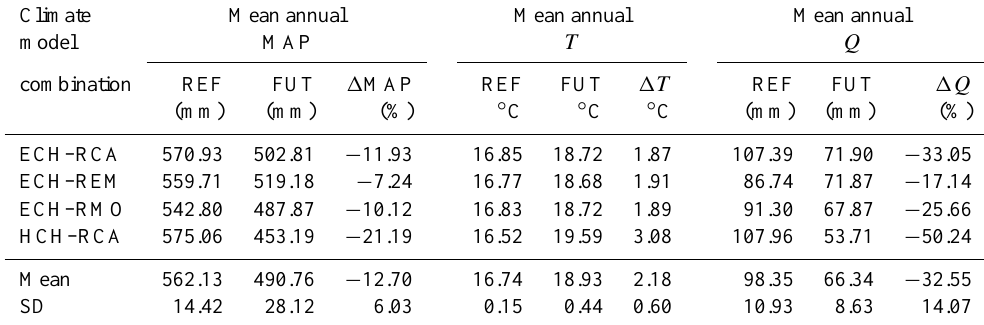
Table 2. Mean annual values of MAP, T and Q in the RMB in REF and FUT periods with relative changes for each CM. The mean and standard deviation (SD) are also reported.